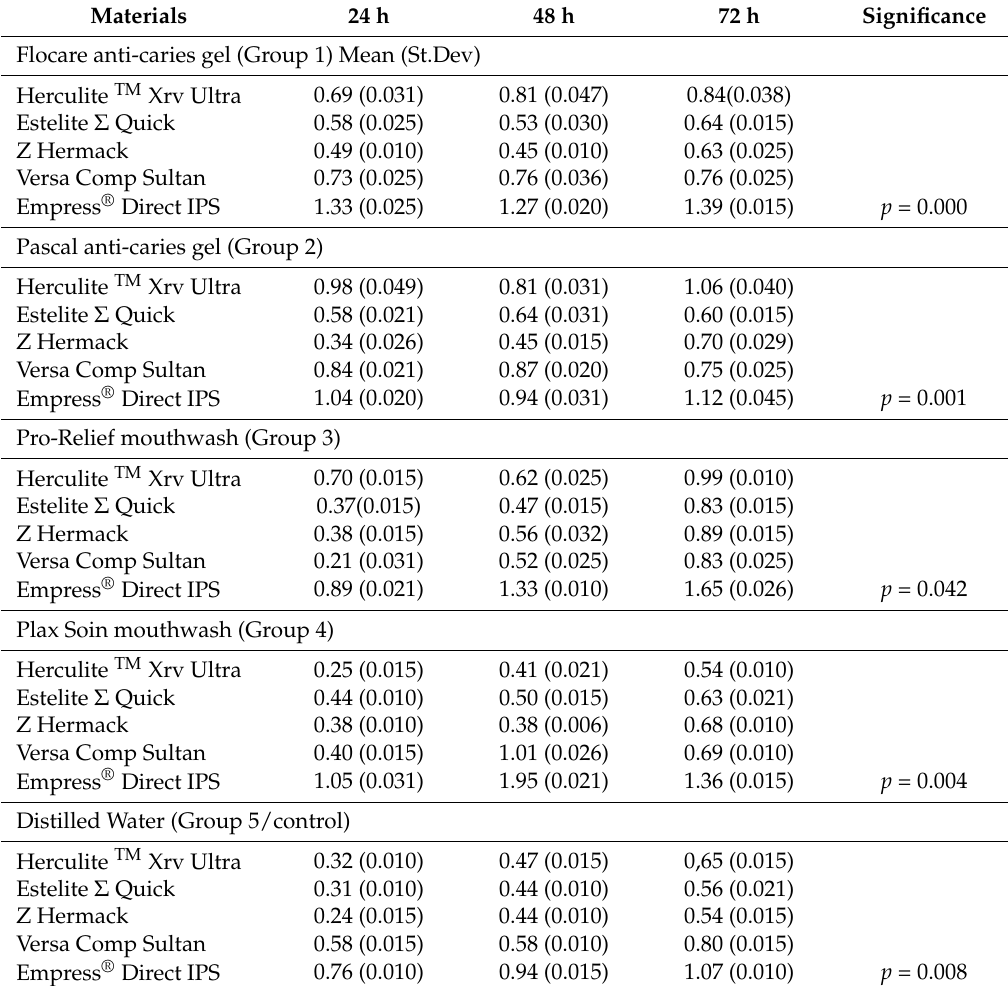
Table 1. The total color difference ( ∆ E* ab ) for tested composite resin materials immersed in mouthwashes/gels (Flocare anti-caries gel, Pascal anti-caries gel, Pro-Relief mouthwash, Plax Soin mouthwash) and the control group, for different aging